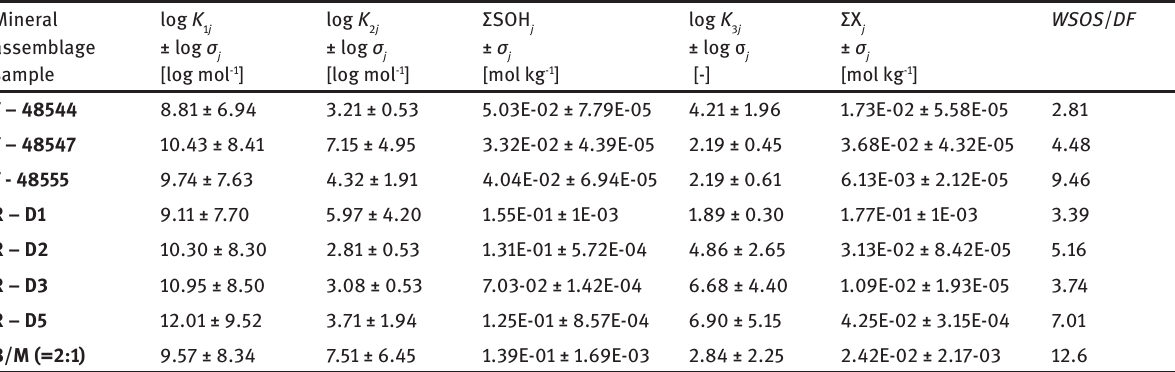
Table 3: Titration curve overall parameters of MA samples F, R and B/M obtained by GC-approach code used to the evaluation of the experimental data (CEM + IExM models were applied; the values of equilibrium constants were extrapolated to I = 0 by means of Davies equation).